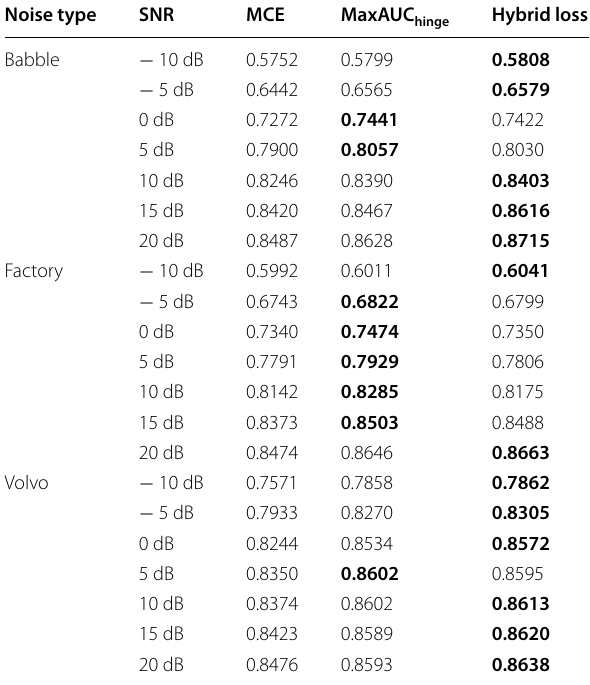
Table 7 AUC results of the comparison VADs with the MaxAUC , MCE and hybrid losses on the Noisy‑CHiME‑4 test dataset, hinge where the Chinese Noisy‑THCHS‑30 dataset was used as the training